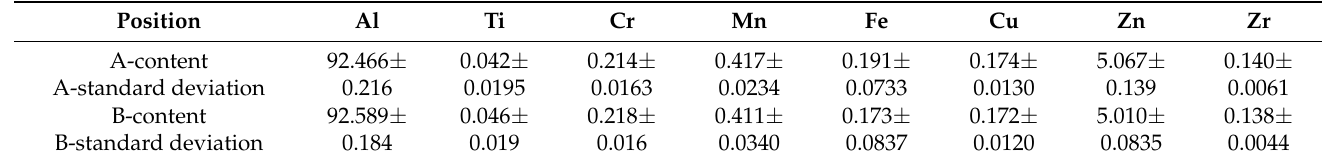
Table 6. Average content results from single point scan (wt%).